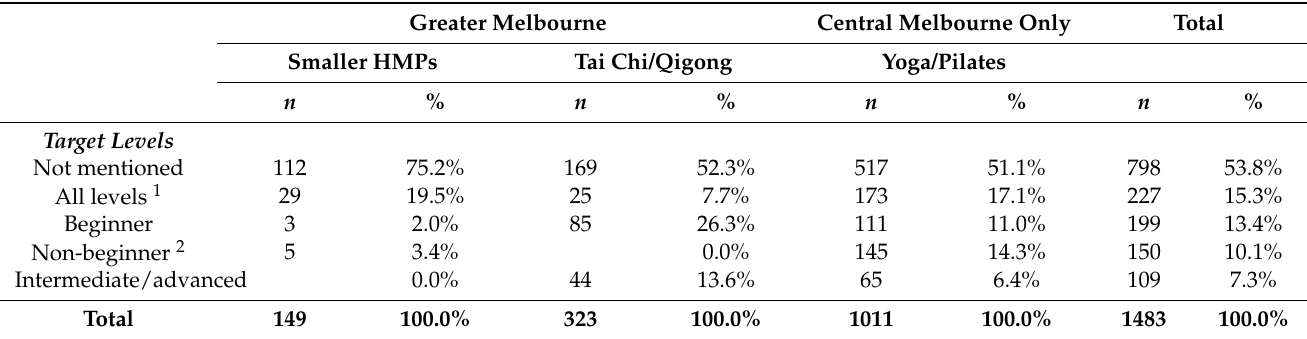
Table 4. Target level and group for the smaller HMPs, Tai Chi/Qigong, and